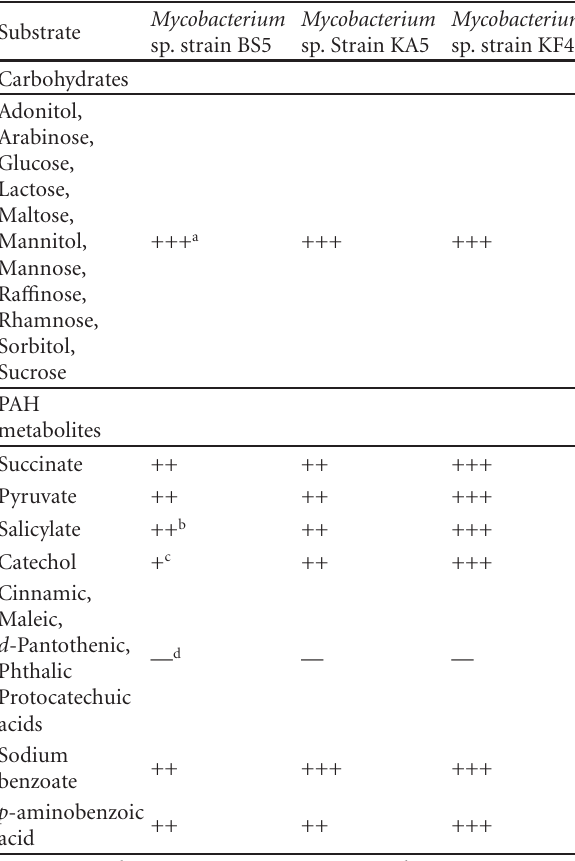
Table 3: Growth of Mycobacterium sp. isolates on various carbohy- drates and potential PAH metabolites. Growth was scored visually on the basis of turbidity and ranked accordingly.